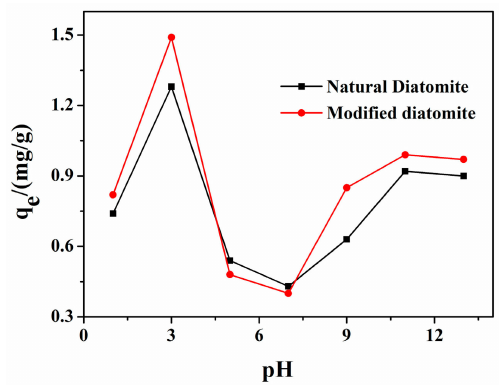
Figure 6. Effect of pH on the removal of 1-NAP by R-D, and C-D ((Experimental conditions: adsorbent = 5.0 g/L; initial concentration = 10 mg/L; V total , 100 mL; T = 45 ◦ C; agitation speed = 140 r/min.).